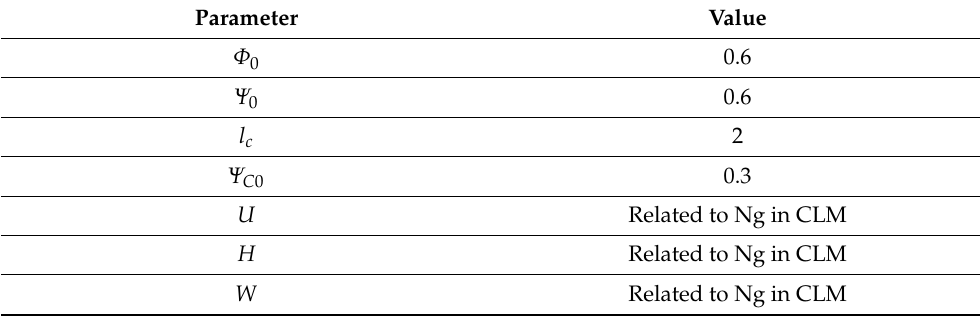
Table 1. Parameters of the extended MG